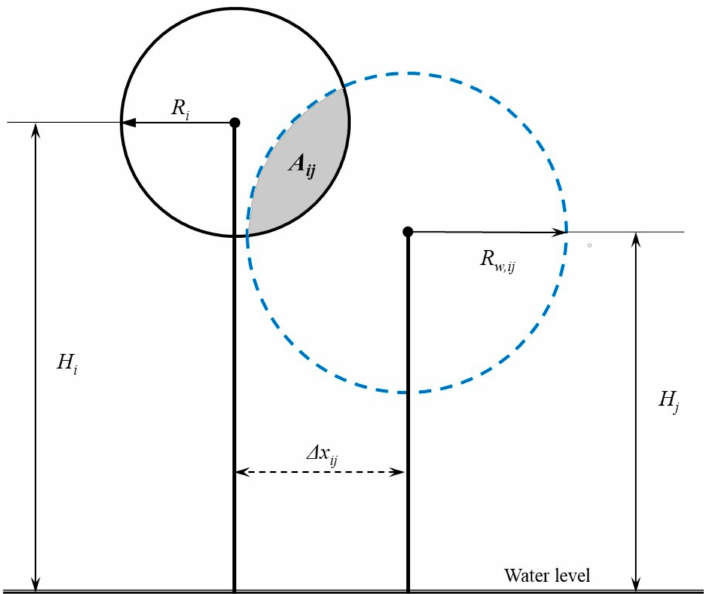
Figure 4. A front view (parallel to wind direction) illustrates the overlap of an upwind turbine wake (the dashed circle) with a downwind turbine rotor (the solid circle)